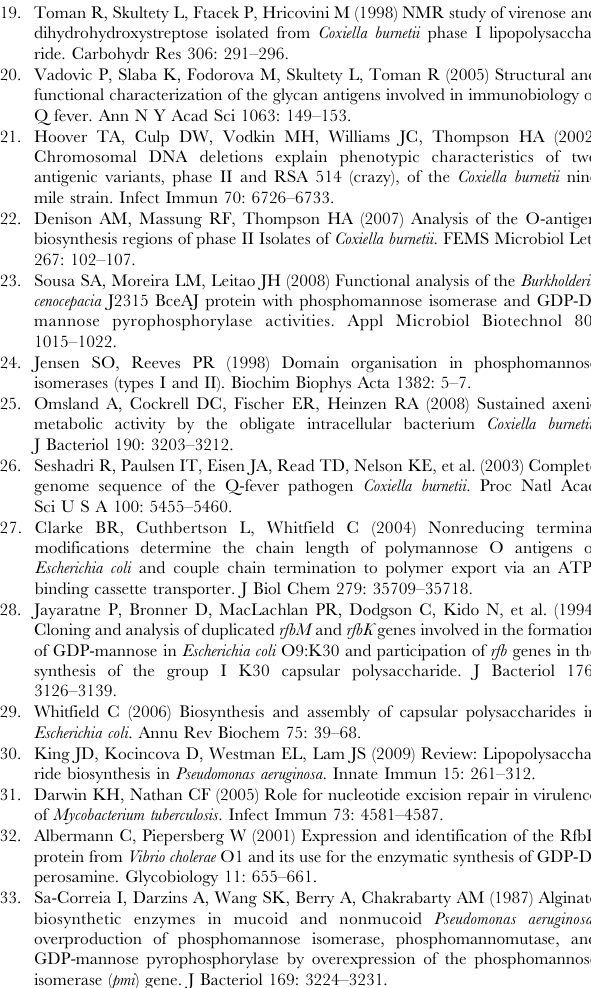
Table S1 Oligonucleotides used in this study. *Intro- duced endonuclease restriction sites are